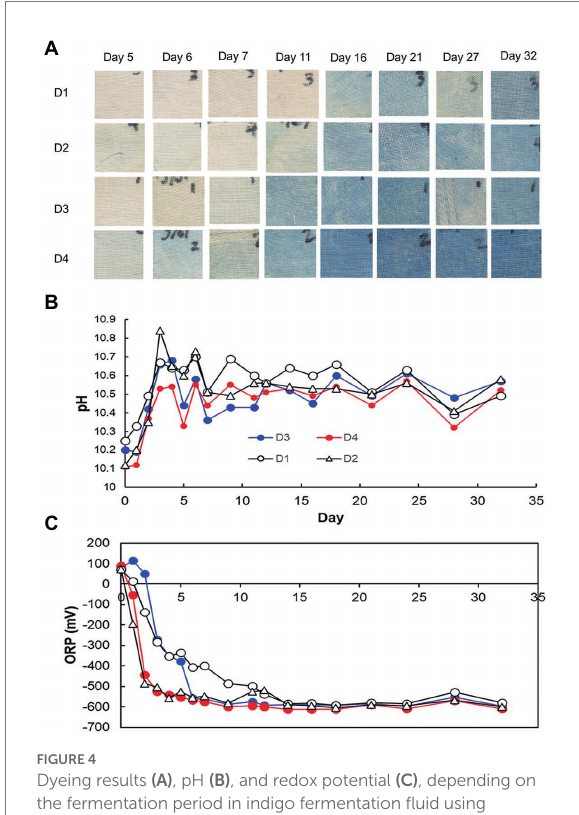
FIGURE 4 Dyeing results (A) , pH (B) , and redox potential (C) , depending on the fermentation period in indigo fermentation fluid using D- sukumo with the addition of Indigofera tinctoria L. leaf powder (LP) added [D2: open triangles and D4: red circles in (B,C) ] and controls [D1: open circles and D3: blue circles in (B,C) ]. Wheat bran was added to batches D3 and D4 on day